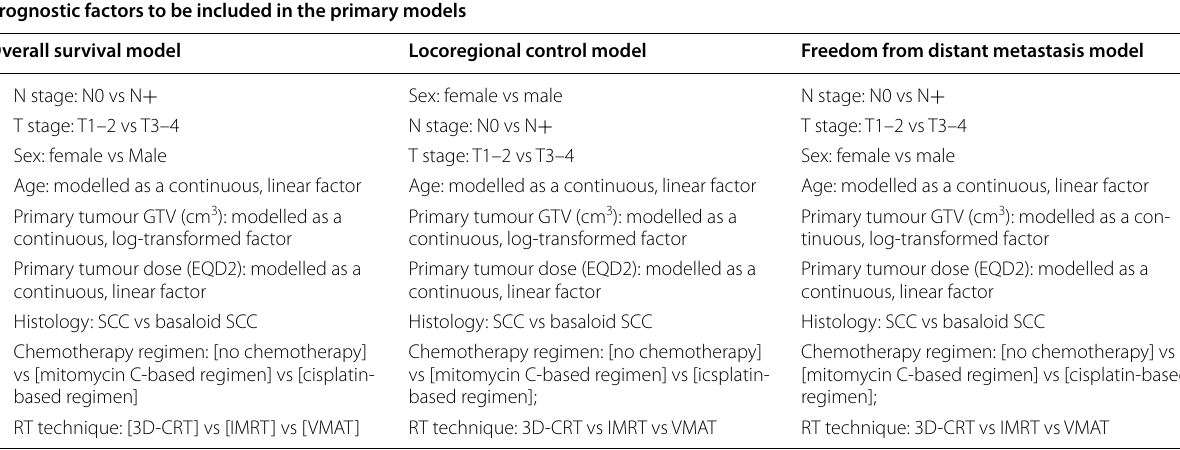
N stage nodal stage, T stage tumour stage, GTV Gross tumour volume, EQD2 Equivalent dose in 2 Gy fractions (α/β Three-dimensional conformal radiation therapy, IMRT Intensity-modulated radiation therapy, VMAT Volumetric modulated arc therapy